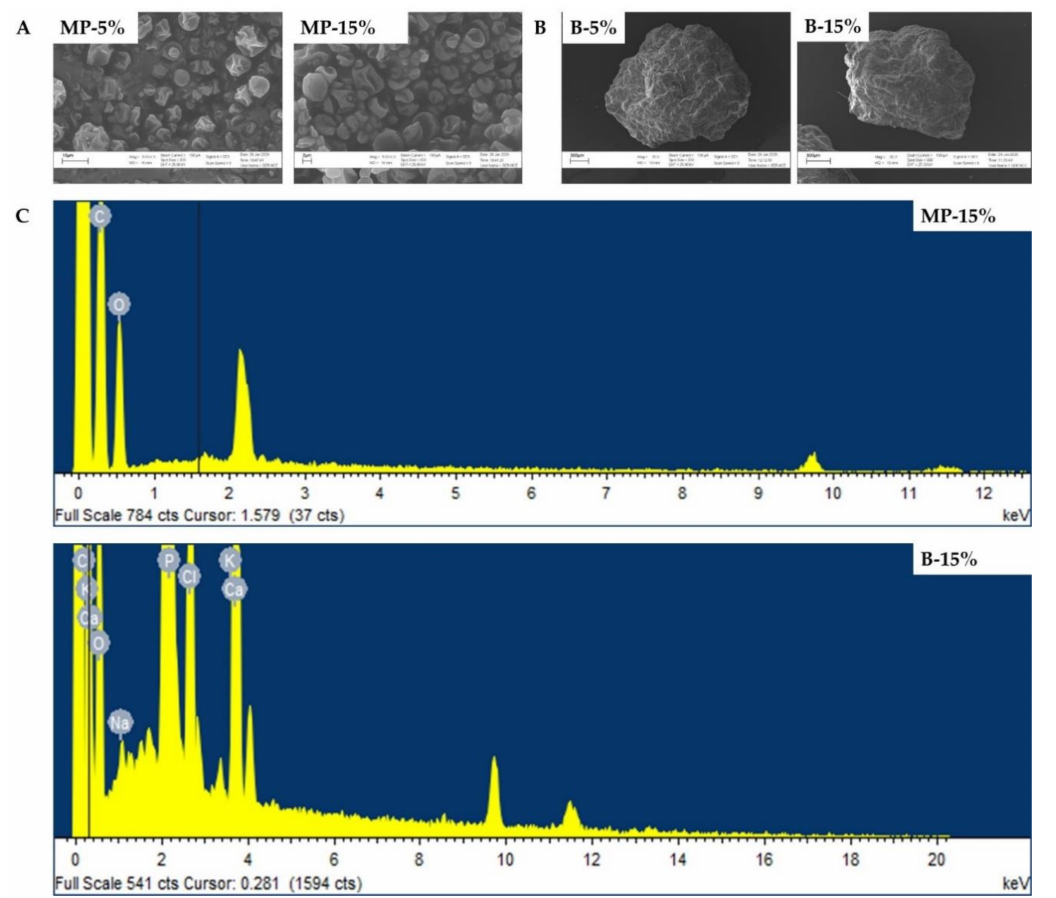
Figure 4. Surface morphology by scanning electron microscopy of microparticles at 5% (MP-5%) and 15% (MP-15%) cochleate of S . Infantis ( A ) and beads at 5% (B-5%) and 15% (B-15%) of cochleates of S . Infanti s ( B ). Elemental composition by energy dispersive X-ray spectroscopy of microparticles (MP) and beads ( B ) at 15% of cochleates of S . Infantis ( C